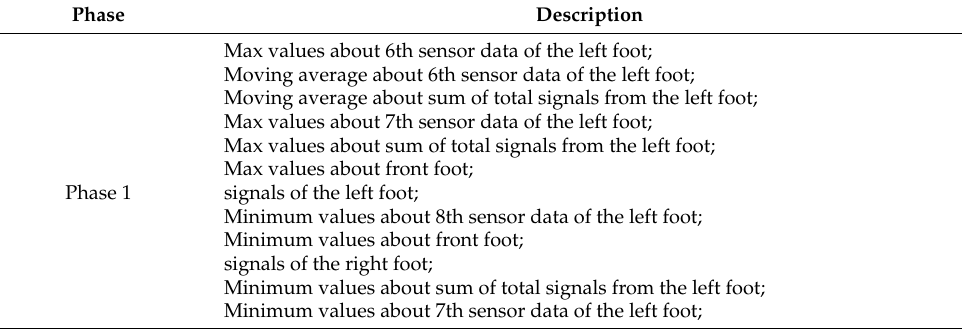
Table 1. Selected features in each phase using mutual